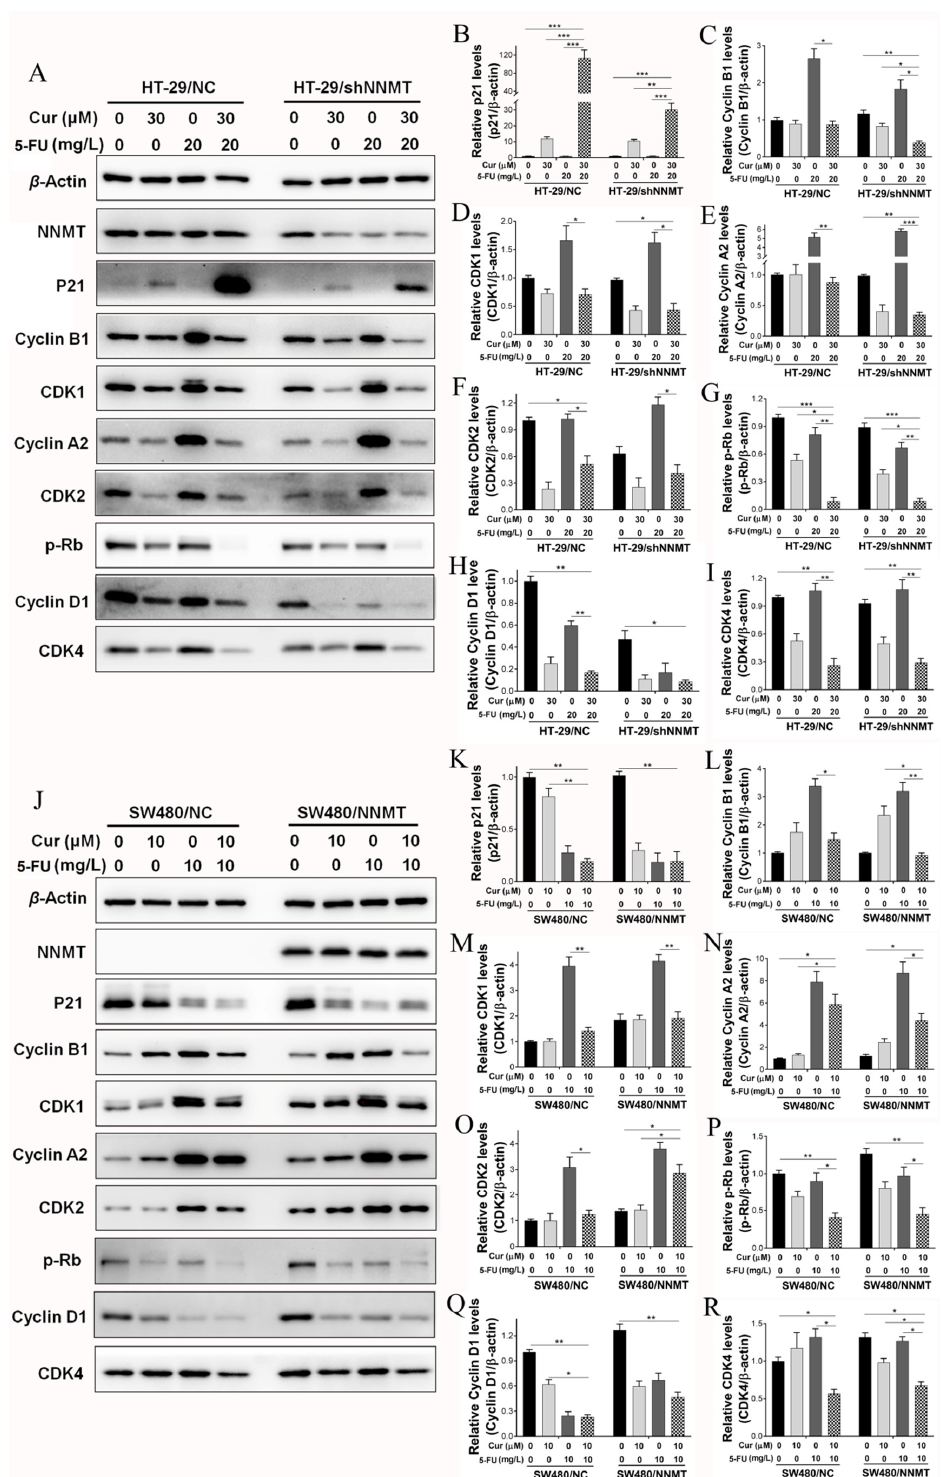
Figure 6. Cur and 5-FU regulate proteins related to cell cycle in CRC cells. Cells were treated with Cur (30 µ M for HT-29 cells; 10 µ M for SW480 cells) and/or 5-FU (20 mg/L for HT-29 cells; 10 mg/L for SW480 cells) for 24 h. ( A – I ) Proteins were analyzed by Western blot and are displayed as a histogram in HT-29 cell lines. The untreated groups of HT-29/NC were used as the control group, which was set as 1; ( J – R ) Proteins were analyzed by Western blot and are displayed as a histogram in SW480 cell lines. The untreated groups of SW480/NC were used as the control group, which was set as 1. 5-FU: 5-Fluorouracil, Cur: curcumin. Data are expressed as means ± SD, n = 3, * p < 0.05, ** p < 0.01, *** p <